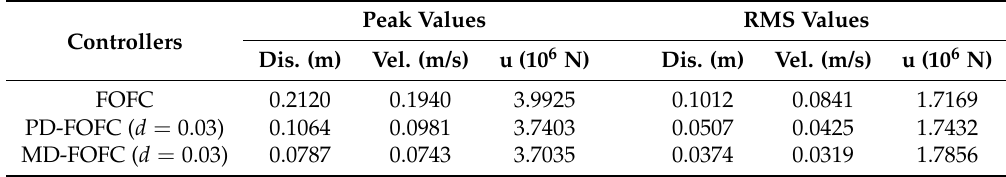
Table 4. Response peak and RMS values of the structure and control force with different